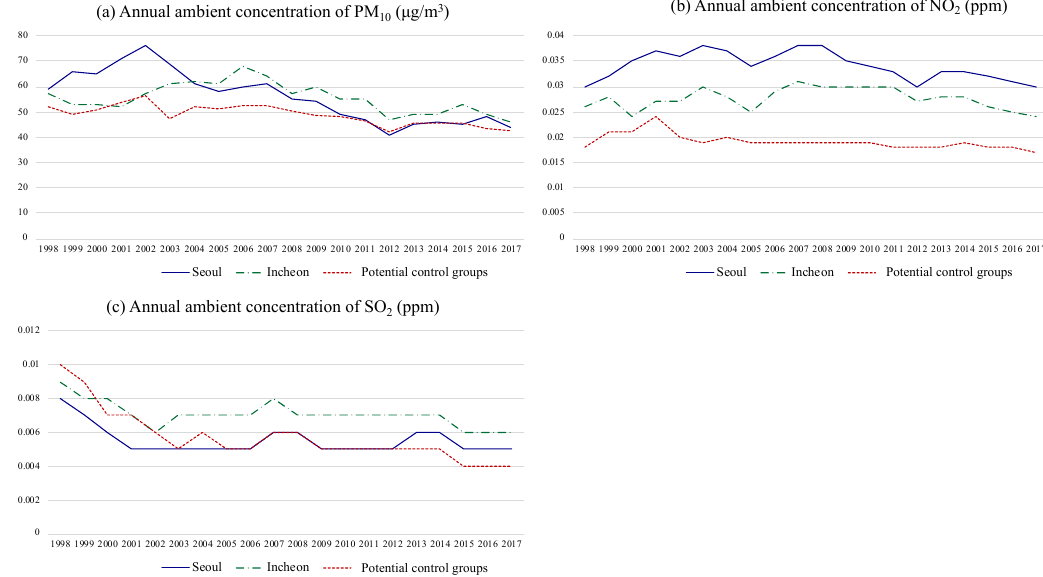
Figure 2. Annual ambient concentration of particulate matters less than 10 µ m (PM 10 ), NO 2 and SO 2 in Seoul, Incheon and the potential control groups.